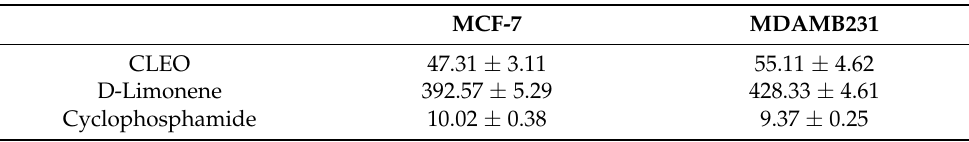
Table 3. Anticancer activity expressed in terms of IC 50 ( µ g/mL) value of the Citrus limetta peel essential